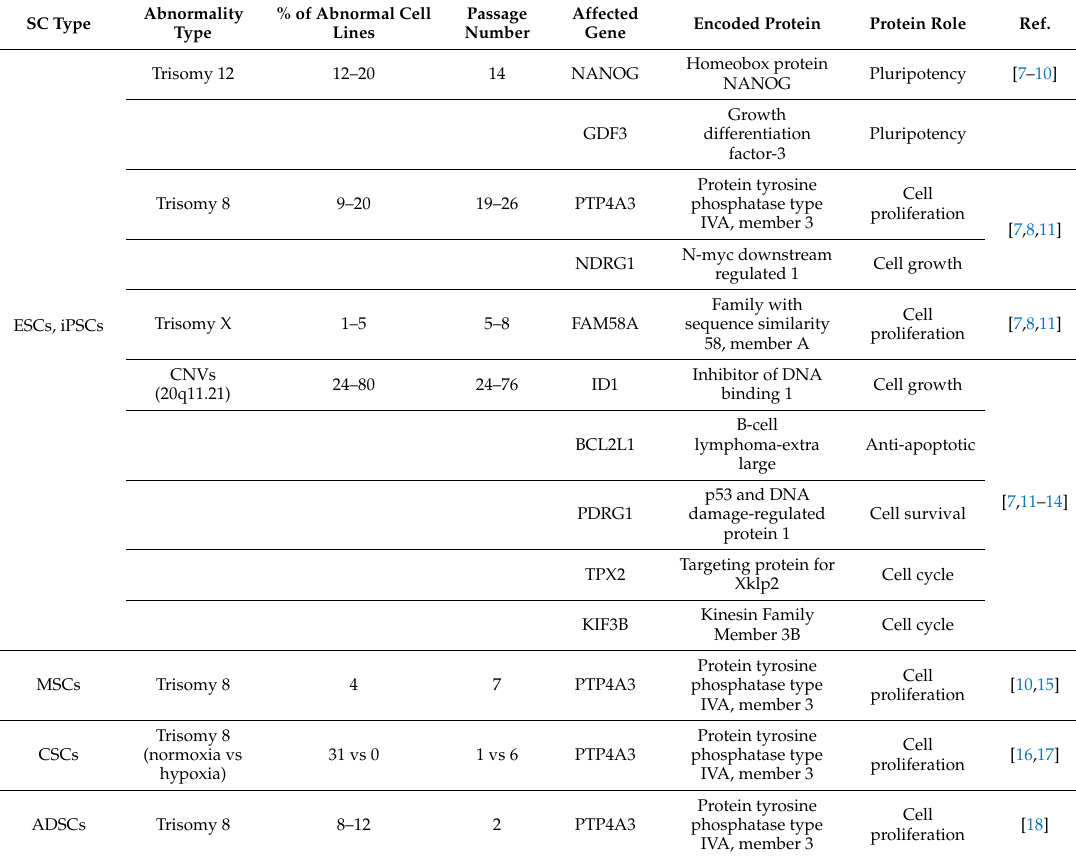
Table 1. Genomic abnormalities in cultured human SCs and affected genes related to pluripotency, cell cycle, growth and